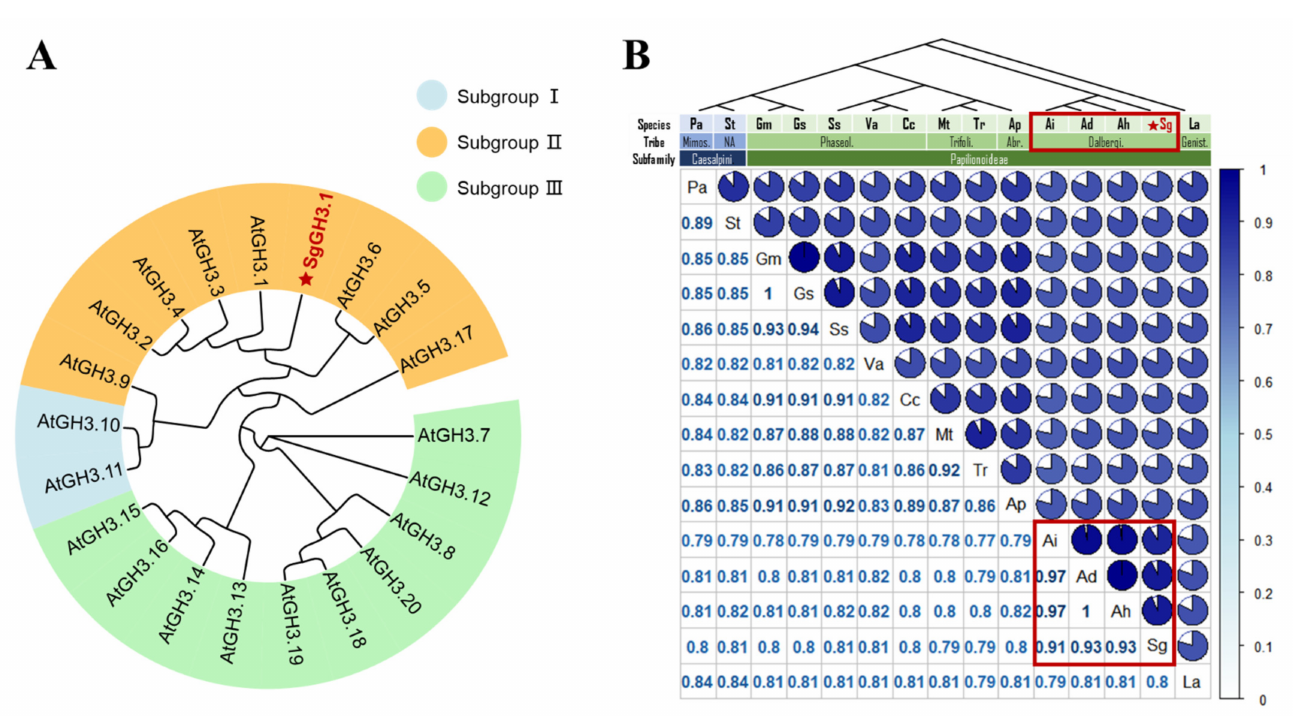
Figure 1. Phylogenetic tree of SgGH3.1 and Arabidopsis Gretchen-Hagen 3 (GH3) proteins ( A ) and percentage identity matrix of SgGH3.1 and GH3.1 homologous proteins of 14 leguminous species ( B ). T-Coffee was used for the multiple alignment and MrBayes for the tree construction. The light blue, orange, and light green indicate Subgroup I, II, and III of GH3 family, respectively. The pie chart on the upper right and the numbers on the lower left of the matrix represent the percentage identities between the leguminous GH3.1 protein sequences. The blue color of the pie charts and numbers indicates the level of the percentage identity (the darker the blue, the higher the percentage identity). The abbreviations on the diagonal line represent different leguminous species: Pa for Prosopis alba , St for Senna tora , Gm for Glycine max , Gs for Glycine soja , Ss for Spatholobus suberectus , Va for Vigna angularis , Cc for Cajanus cajan , Mt for Medicago truncatula , Tr for Trifolium repens , Ap for Abrus precatorius , Ai for Arachis ipaensis , Ad for Arachis duranensis , Ah for A. hypogaea , Sg for S. guianensis , and La for Lupinus albus . The tree above the matrix is based on the phylogenetic analysis of the 15 leguminous GH3.1 protein